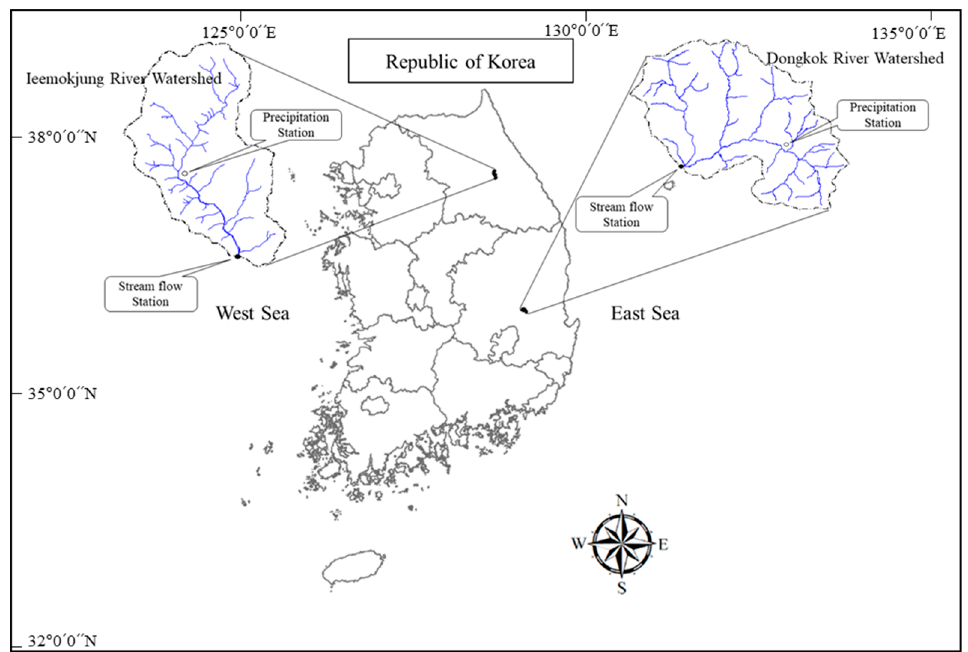
Figure 1. Location of the Dongkok (Lat: 36°07’11” N, Lon: 128°47’46” E) and Ieemokjung (Lat: 37°37’17” N, Lon: 128°28’19” E) watersheds in South Korea.